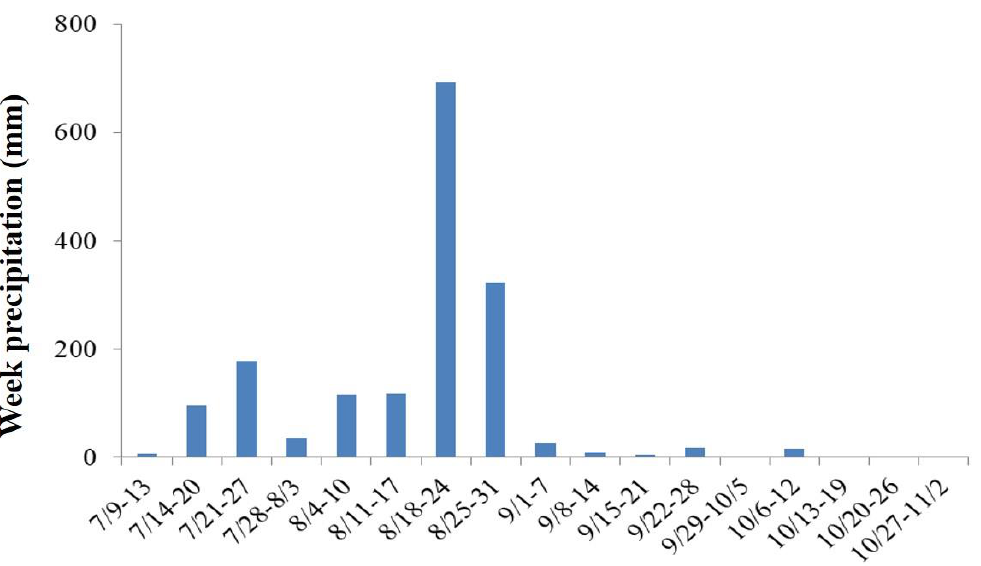
Figure 4. Weekly precipitation (mm) obtained from meteorological station in study area.